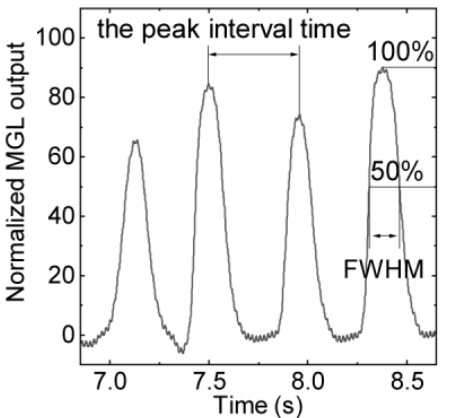
Figure 4. MG sensor output during the teeth-tapping task.